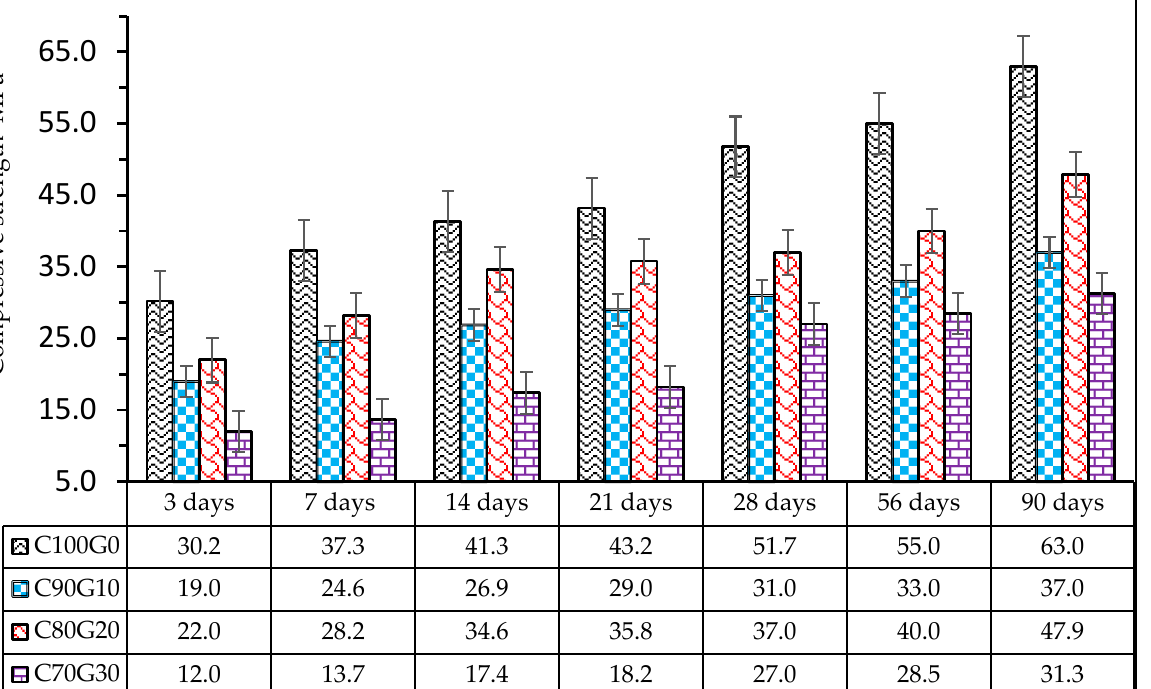
Figure 10. Compressive strength of glass blended concrete. The rate of strength development in C 70 G 30 is higher (48.3 wt.%) between 21–28 days 3.35% between 21–28 days, whereas the development was 19.75% between 56–90